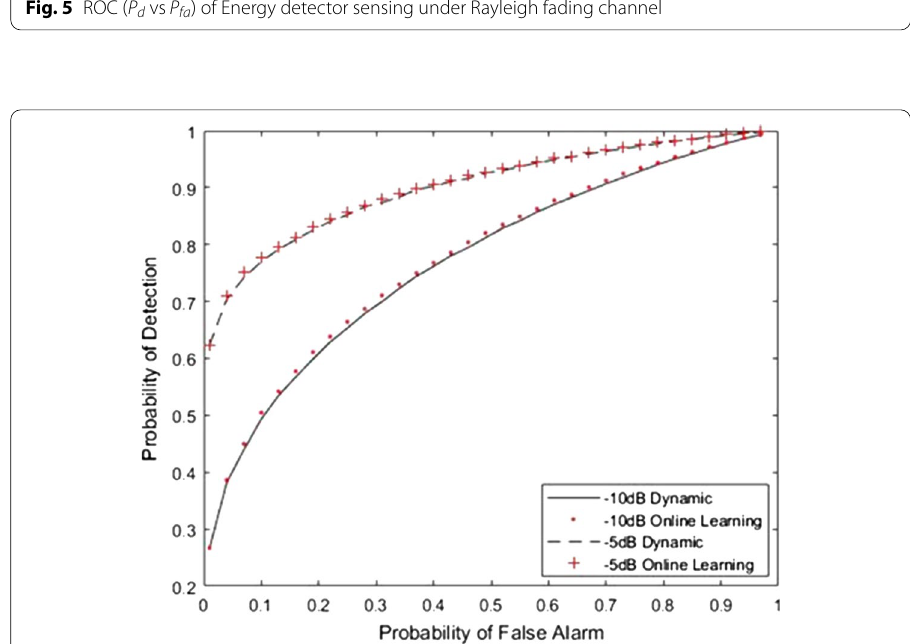
Fig. 6 ROC ( P d vs P fa ) of energy detector sensing under Nakagami- m fading channel ( m